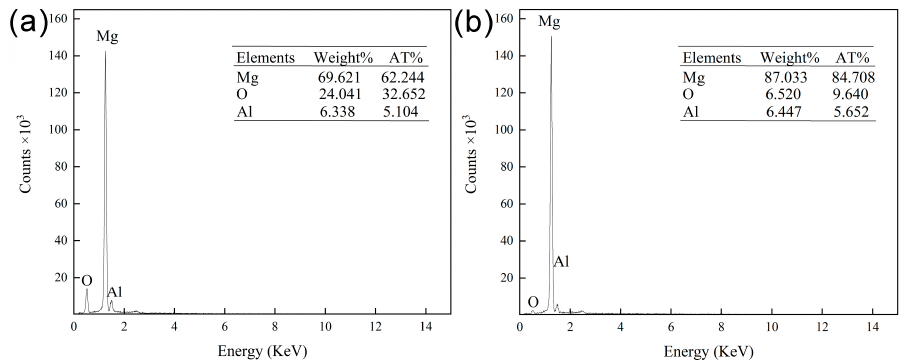
Figure 8. Results of EDS analysis of surfaces performed at: ( a ) arrow 1 in Figure 7a, ( b ) arrow 2 in Figure 7c.